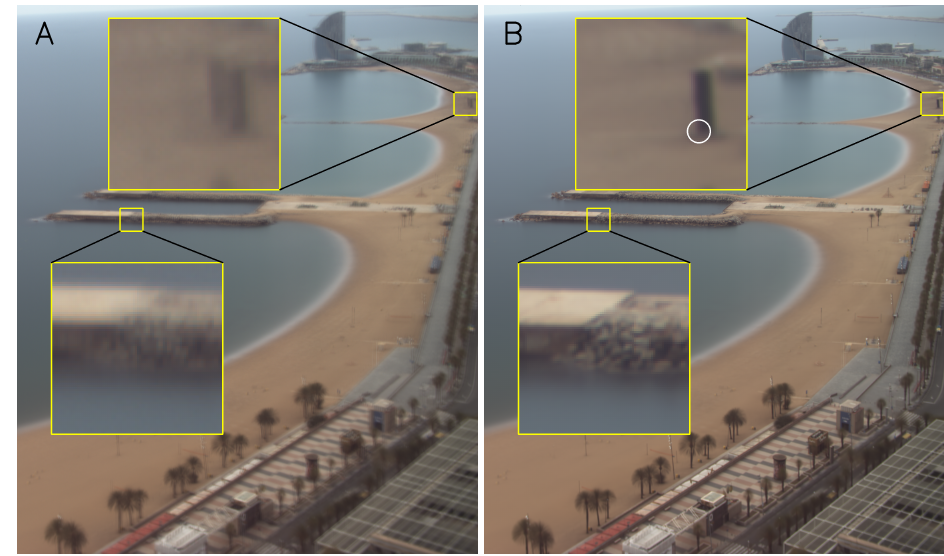
Figure 11. BCN2 with n p = 4, f C = 5pixels and K C = 4: time average of images before ( A ) and after ( B ) stabilization.